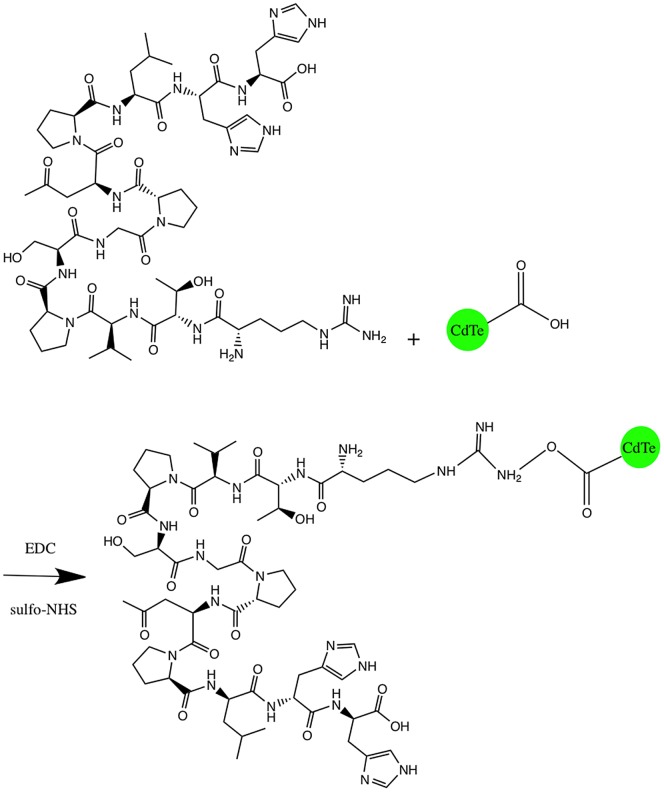
Zero-coupling procedure for conjunction of the CLAVATA3 (CLV3) dodecapeptide and CdTe QDs.